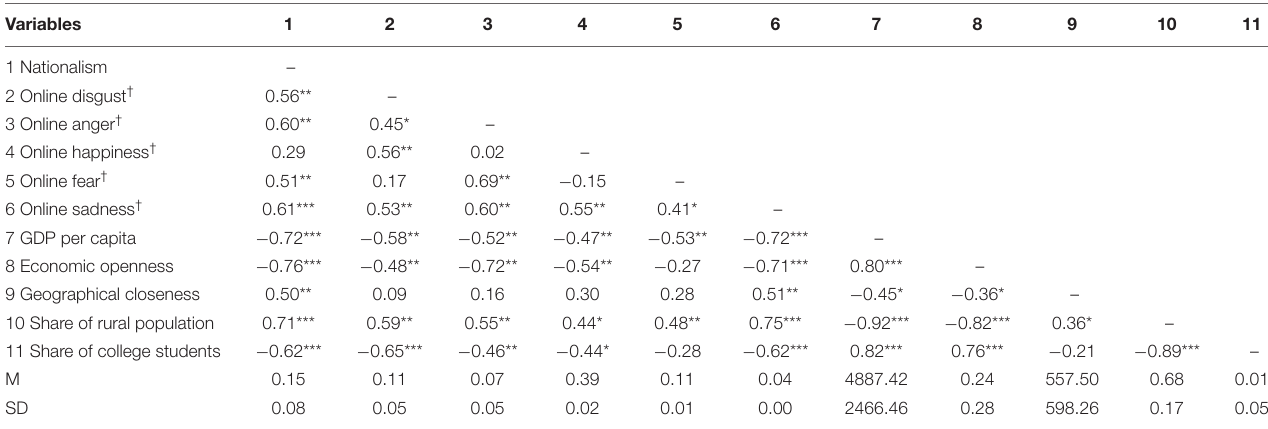
FIGURE 2 | Nationalism of 31 provinces in China, 2014. TABLE 1 | Descriptive statistics and correlations among